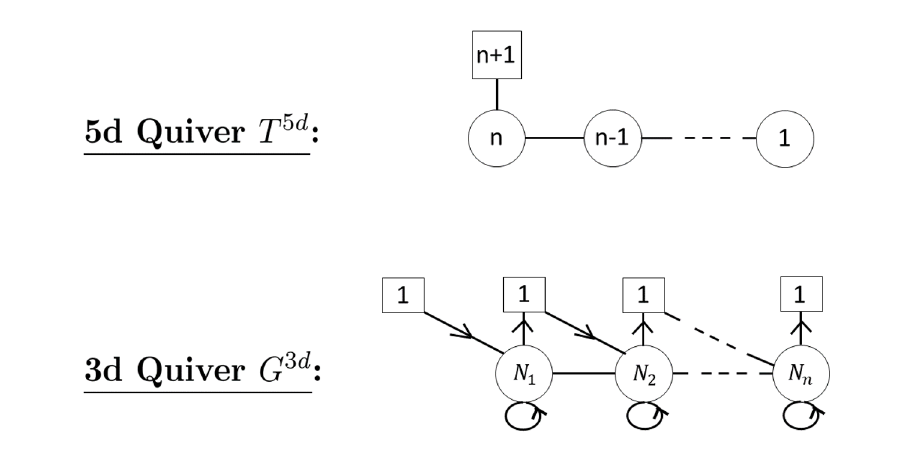
Figure 2. Sphere with 3 full A n punctures: 5d theory T 5d and 3d theory G 3d resulting from W S